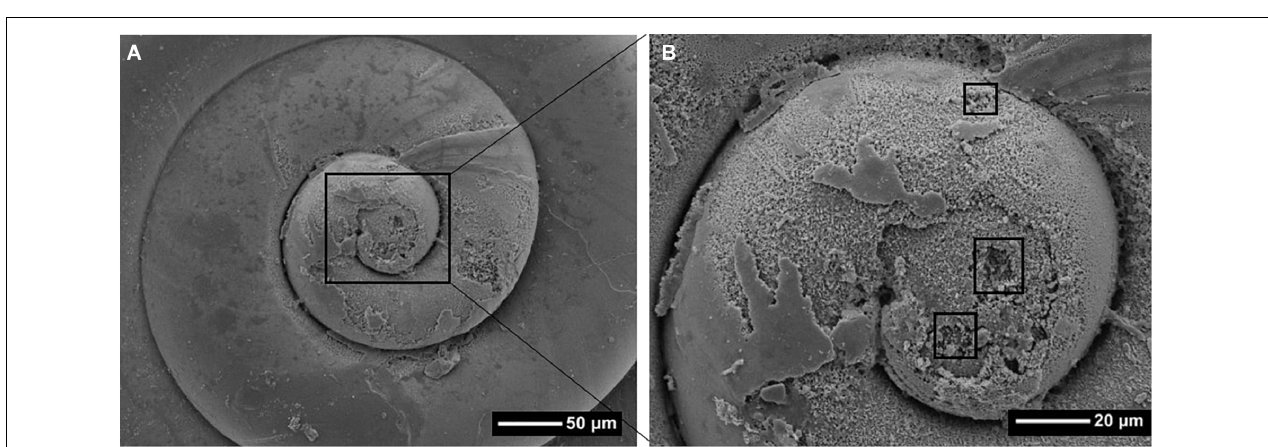
FIGURE 7 | Scanning Electron Microscope (SEM) image (A) showing the distribution of dissolution on a Limacina helicina shell collected near Cape Bathurst in 2017. In panel (B) , damage on the first whorl is shown in greater detail with the squares indicating deeper-protruding Type III dissolution.